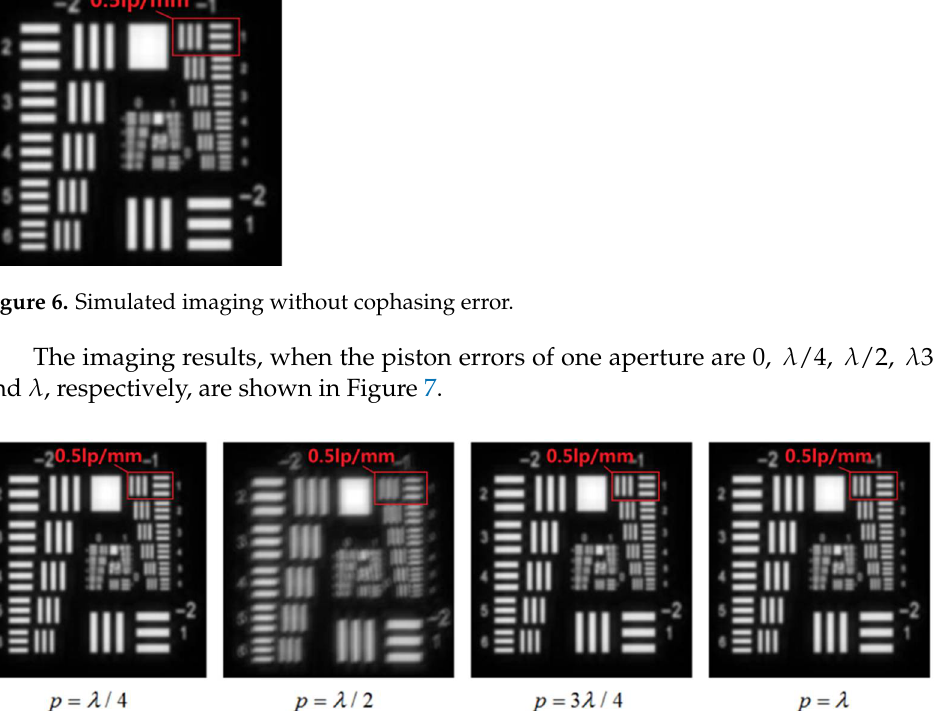
Figure 7. Simulated imaging with different piston errors.